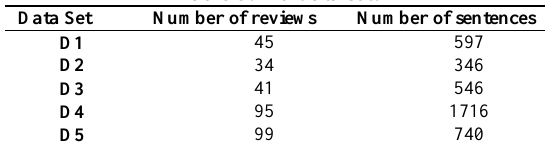
Table 8. Liu data set.